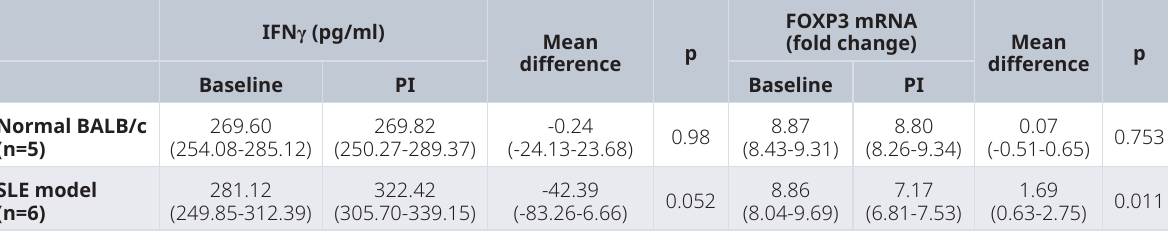
Table 1. Comparison of IFN γ levels and FOXP3 mRNA expression before and after induction with intraperitoneal pristane. Data are presented as mean (95% confidence interval). SLE, systemic lupus erythematosus; PI, post